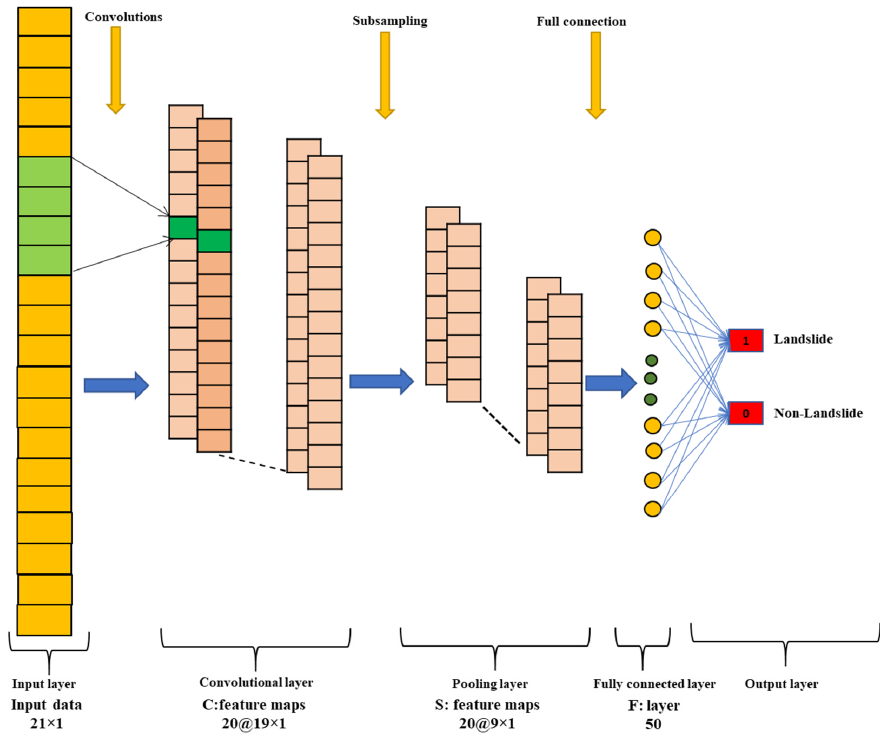
Water 2021 , 13 , x FOR PEER REVIEW Figure 5. Structure of the CNN model . Figure 5. Structure of the CNN model.